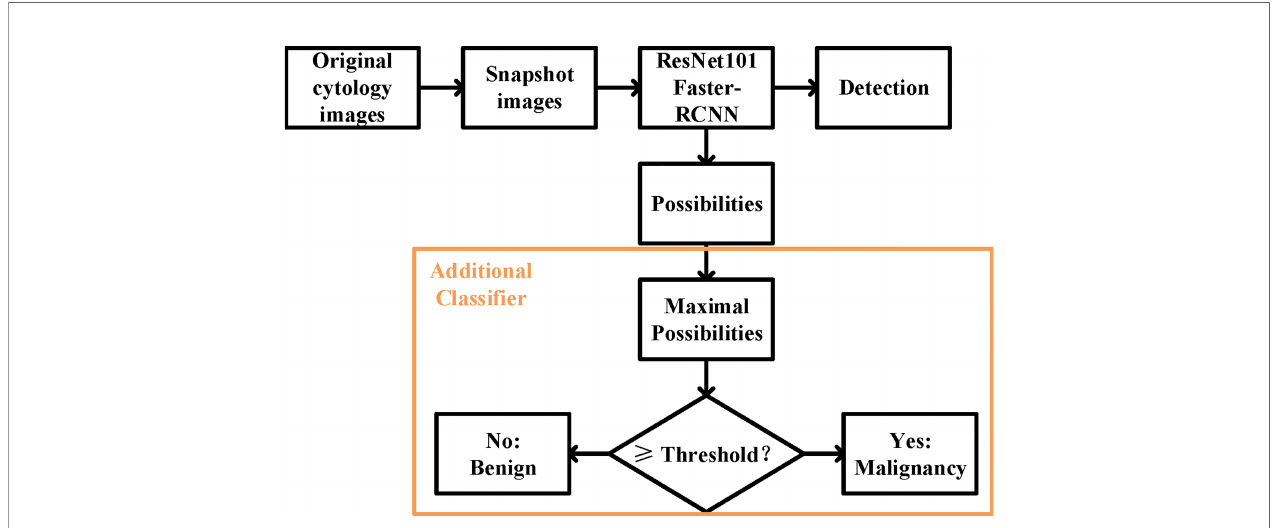
FIGURE 2 | The overall design of the deep learning system. The ResNet 101 Faster-RCNN detected the UC cells while assigning a possibility to each of the cell, and an additional classi fi er picked the maximal possibility and predicted the histopathological malignant state according to the set